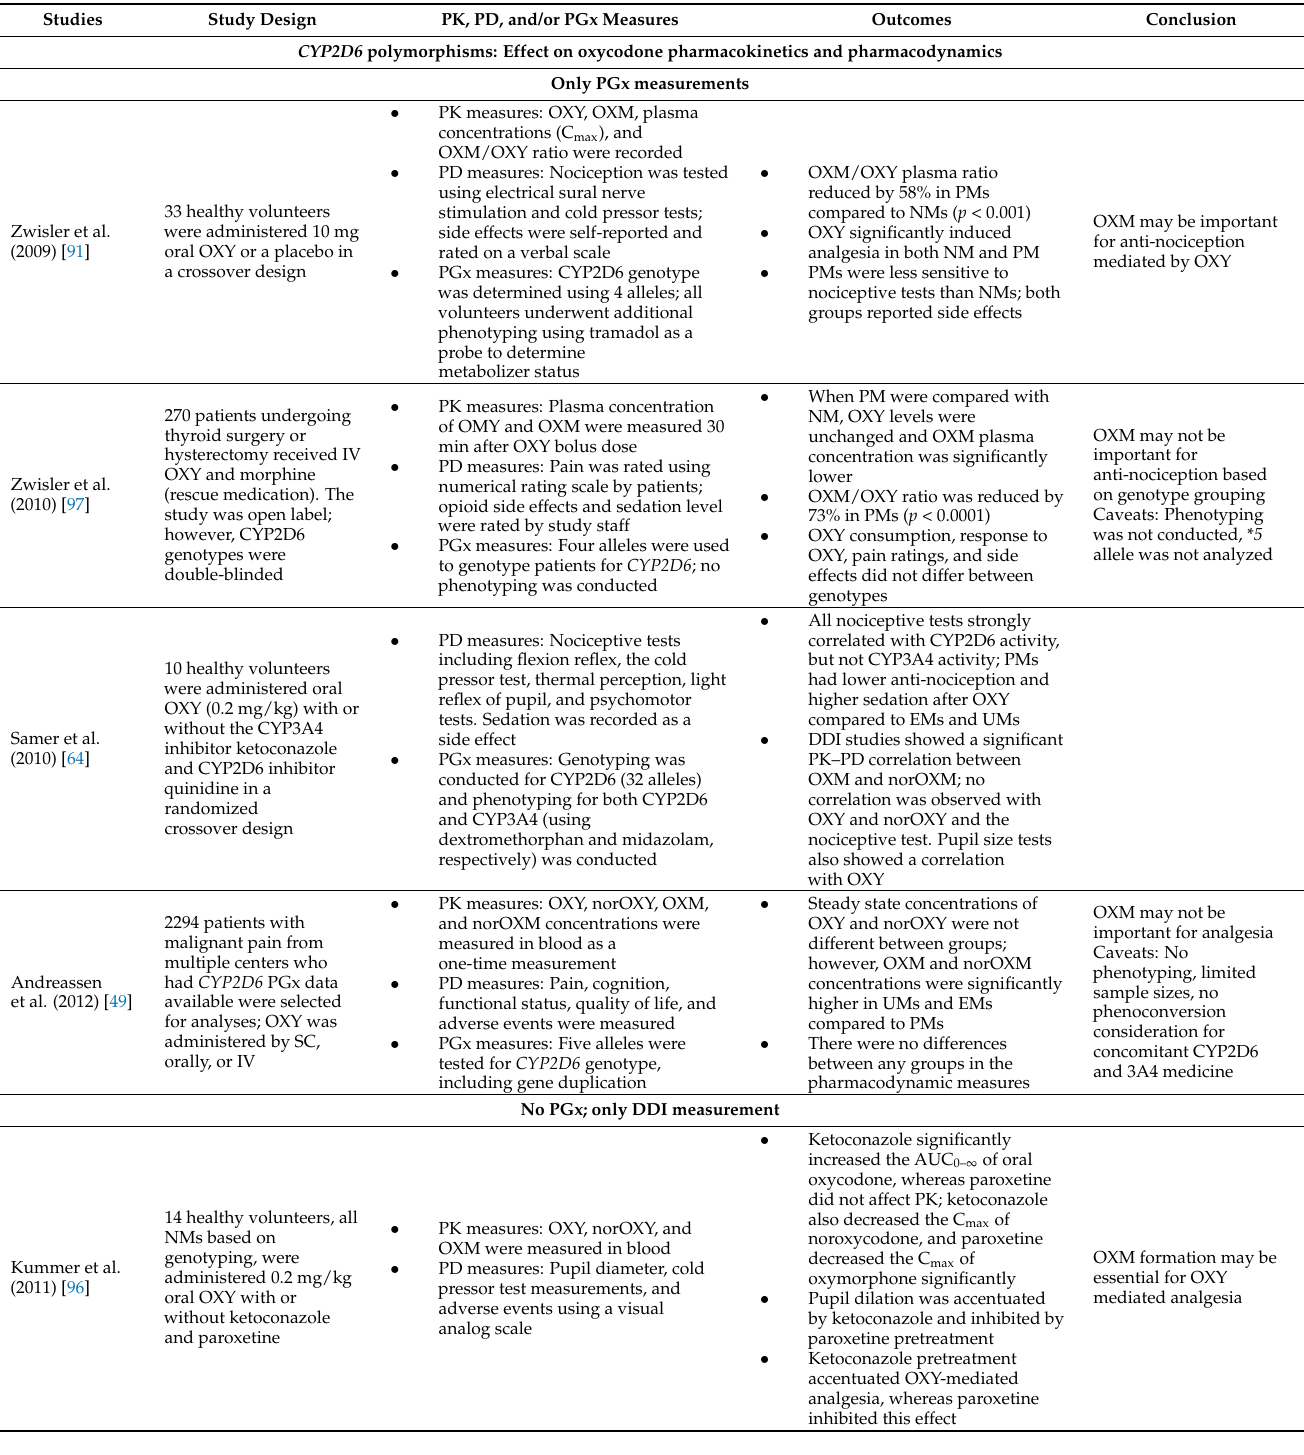
Table 2. Summary of studies reviewed in this text with their design, measures, and